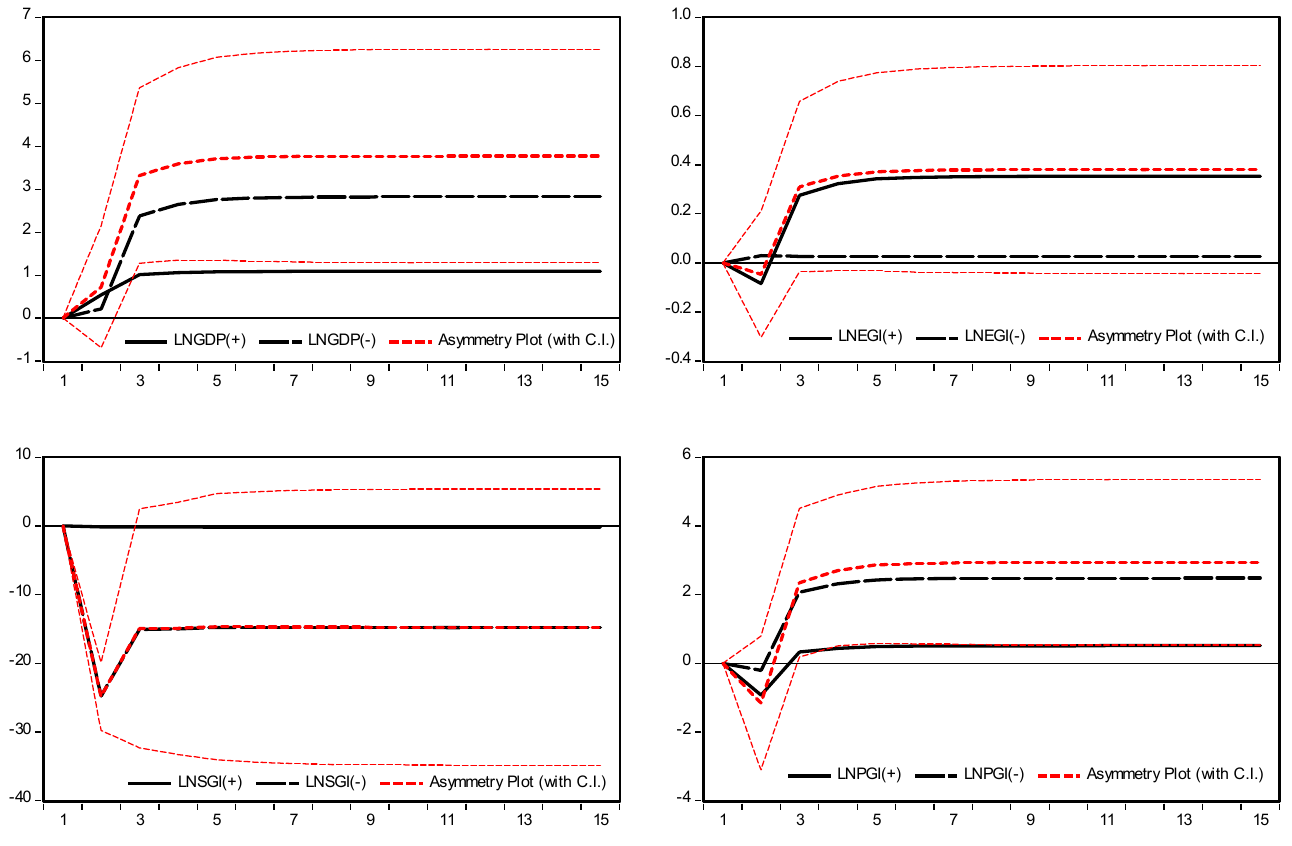
Figure 7. Accumulative dynamic multiplier plots.